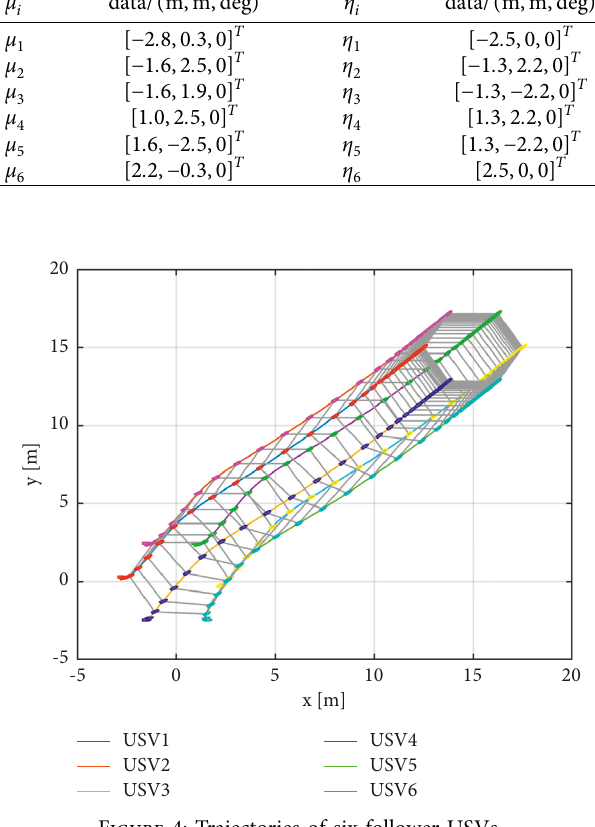
Figure 4: Trajectories of six follower